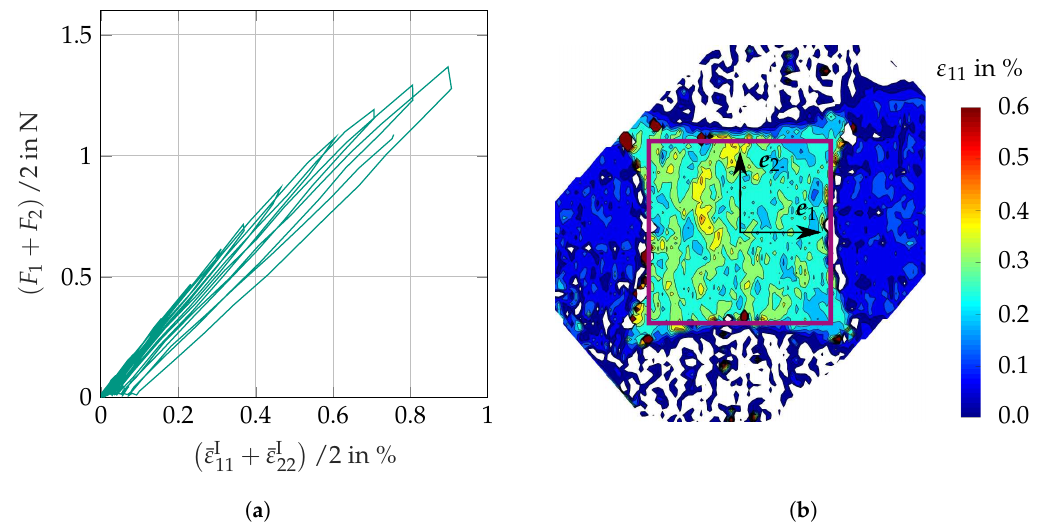
Figure 17. Geometry 2 with continuous fiber reinforced arms with loading scenario P Γ = 1 . ( a ) Force over strain, average values over the e 1 - and the e 2 -direction; ( b ) Contour plot of the normal strain ε 11 = at ε I 11